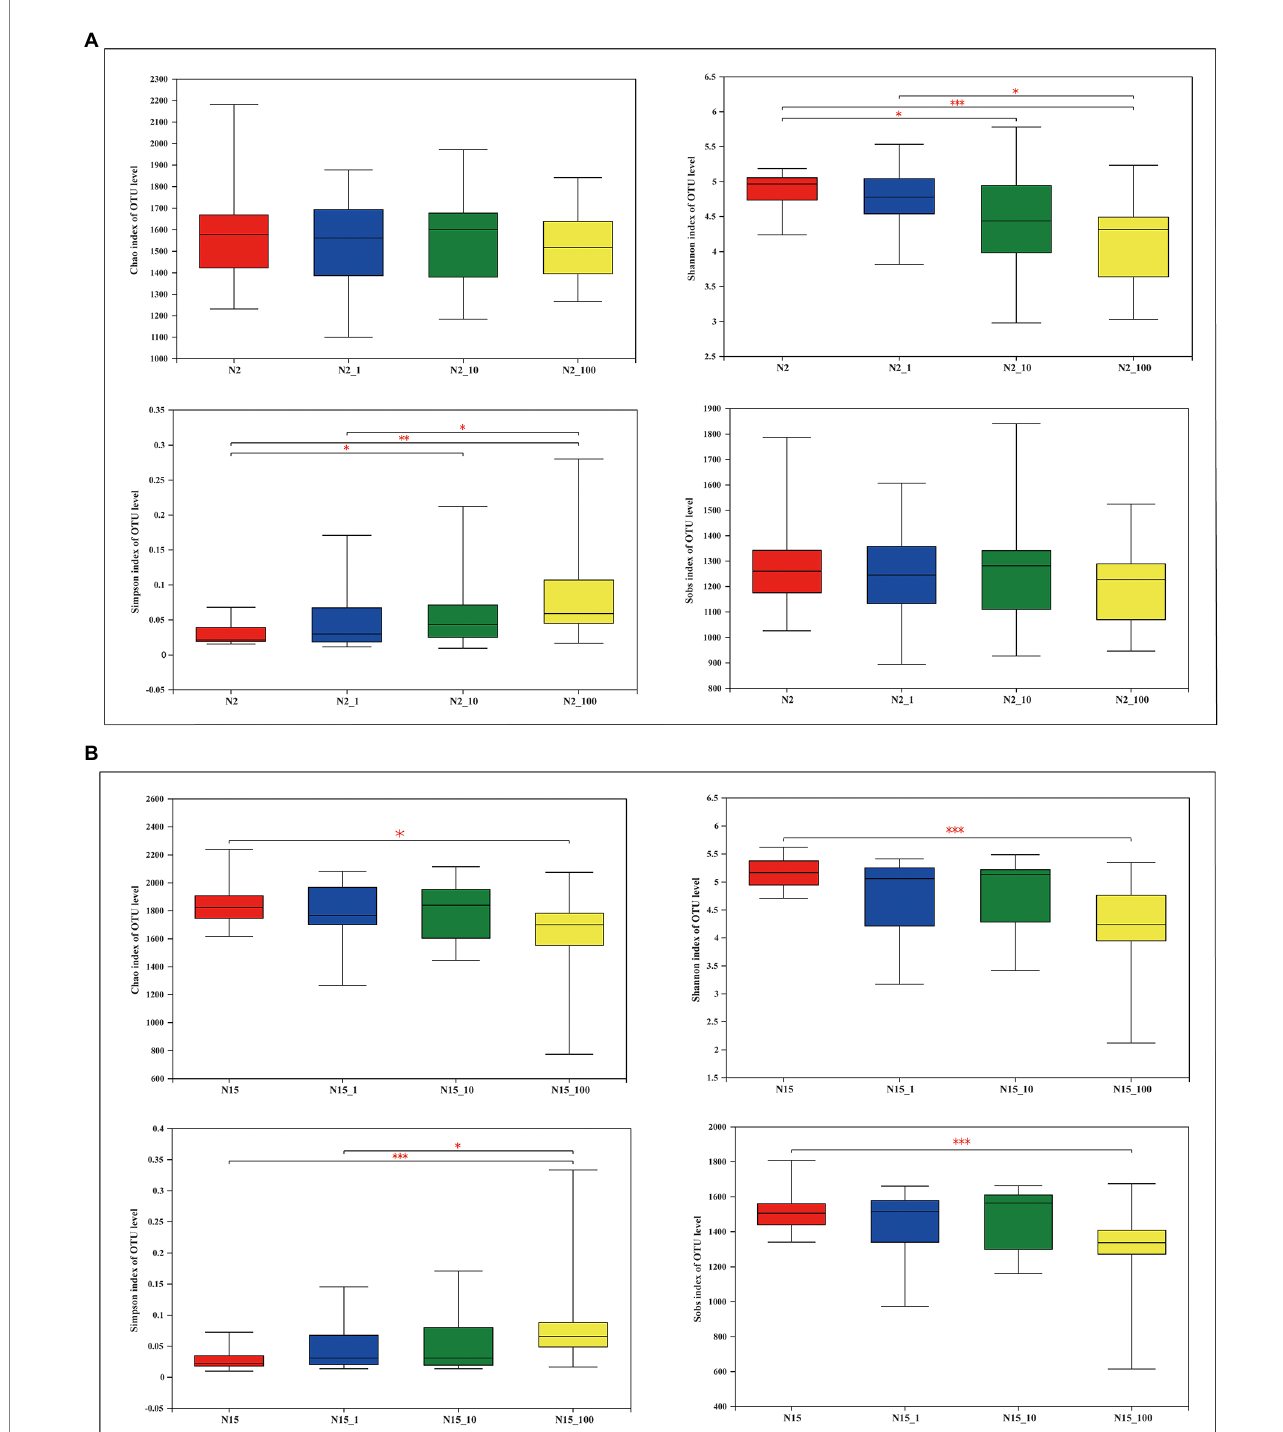
FIGURE 2 Overview of α -diversity measurements at the OTU level for different concentrations of E1 in the water samples from sites N2 and N15. (A) Site N2: the four images represent the Chao richness estimator, Shannon index, Simpson index and Sobs index; (B) Site N15: the four images represent the Chao richness estimator, Shannon index, Simpson index and Sobs index. *Indicates 0.01 < p ≤ 0.05, **indicates 0.001 < p ≤ 0.01, *** indicates p ≤